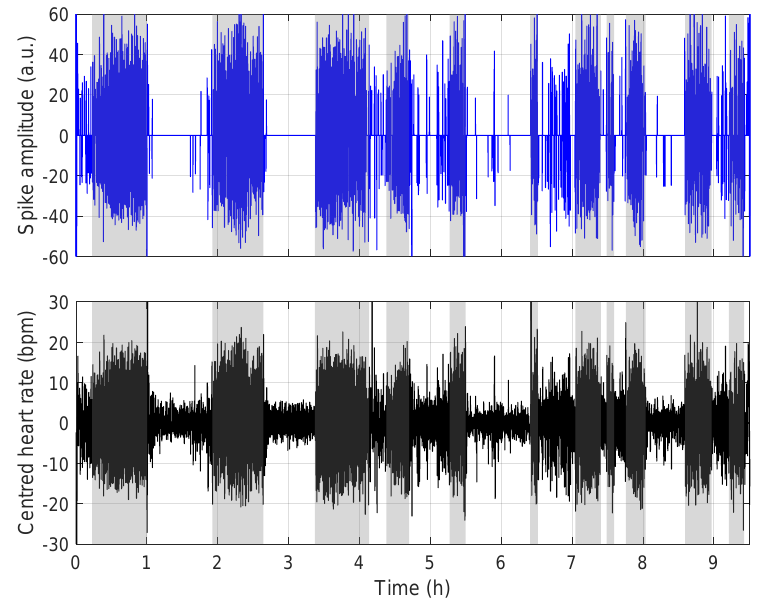
Figure 15. PhysioNet: recording “A-03”, an example where our model works as expected. The same representation as in Figure 9. In this recording, bradycardia–tachycardia associated with apnoea appear clearly on the sparse decomposition, allowing for a very good detection of apnoea.